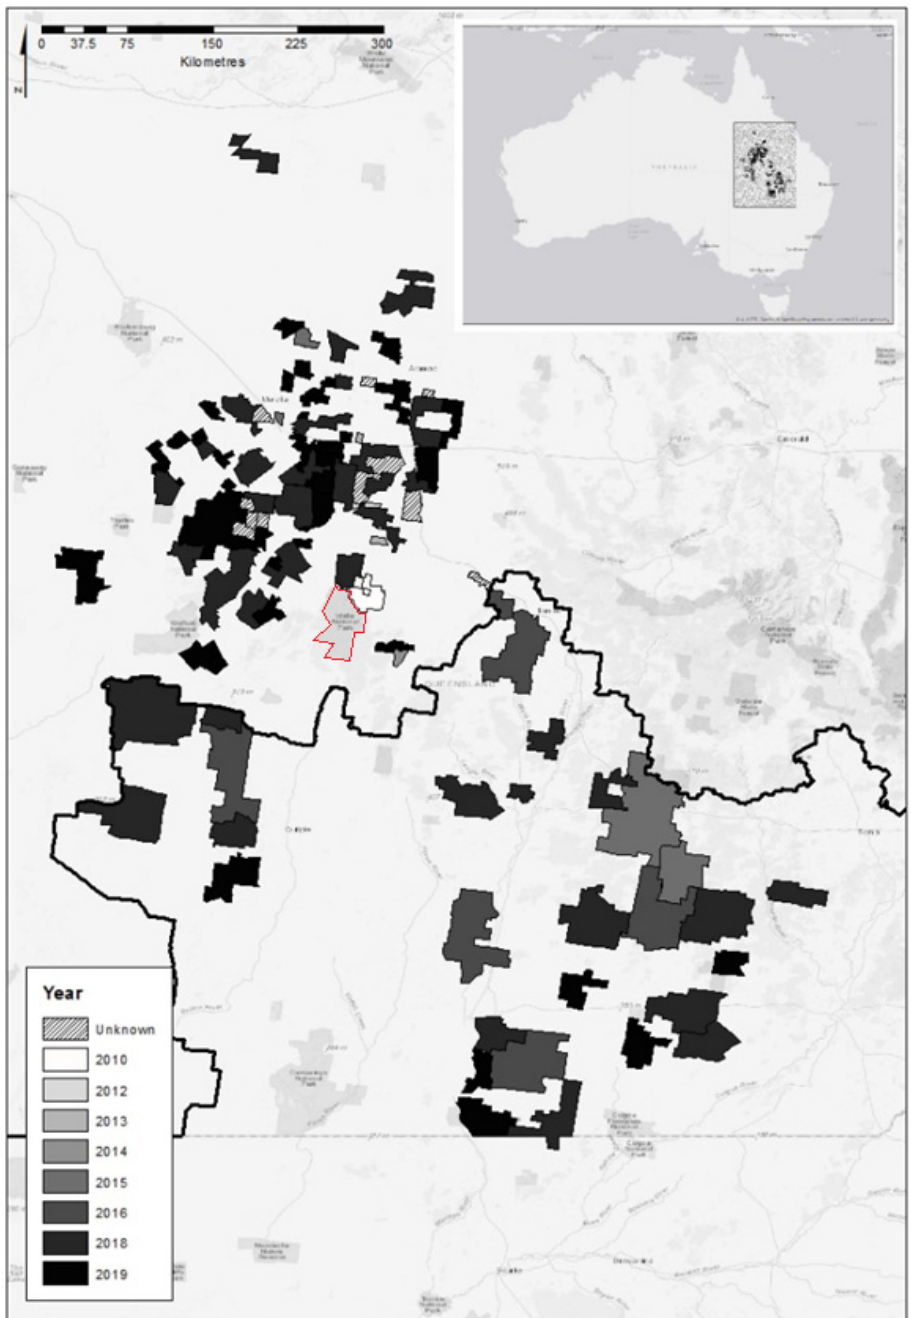
Figure 2. Map of pest exclusion or cluster fenced areas in Central-Western and South-Western Queensland as at December 2019. Shaded by final funding year or known year of completion. Unknown completion years of privately funded exclusion fences are indicated by hatching. Black line shows the location of the national dingo barrier fence (designed to help manage dingoes in the southern part of this area). Map generated in ArcMap v10.5.1. Red polygon shows Idalia National Park (see Discussion for details).